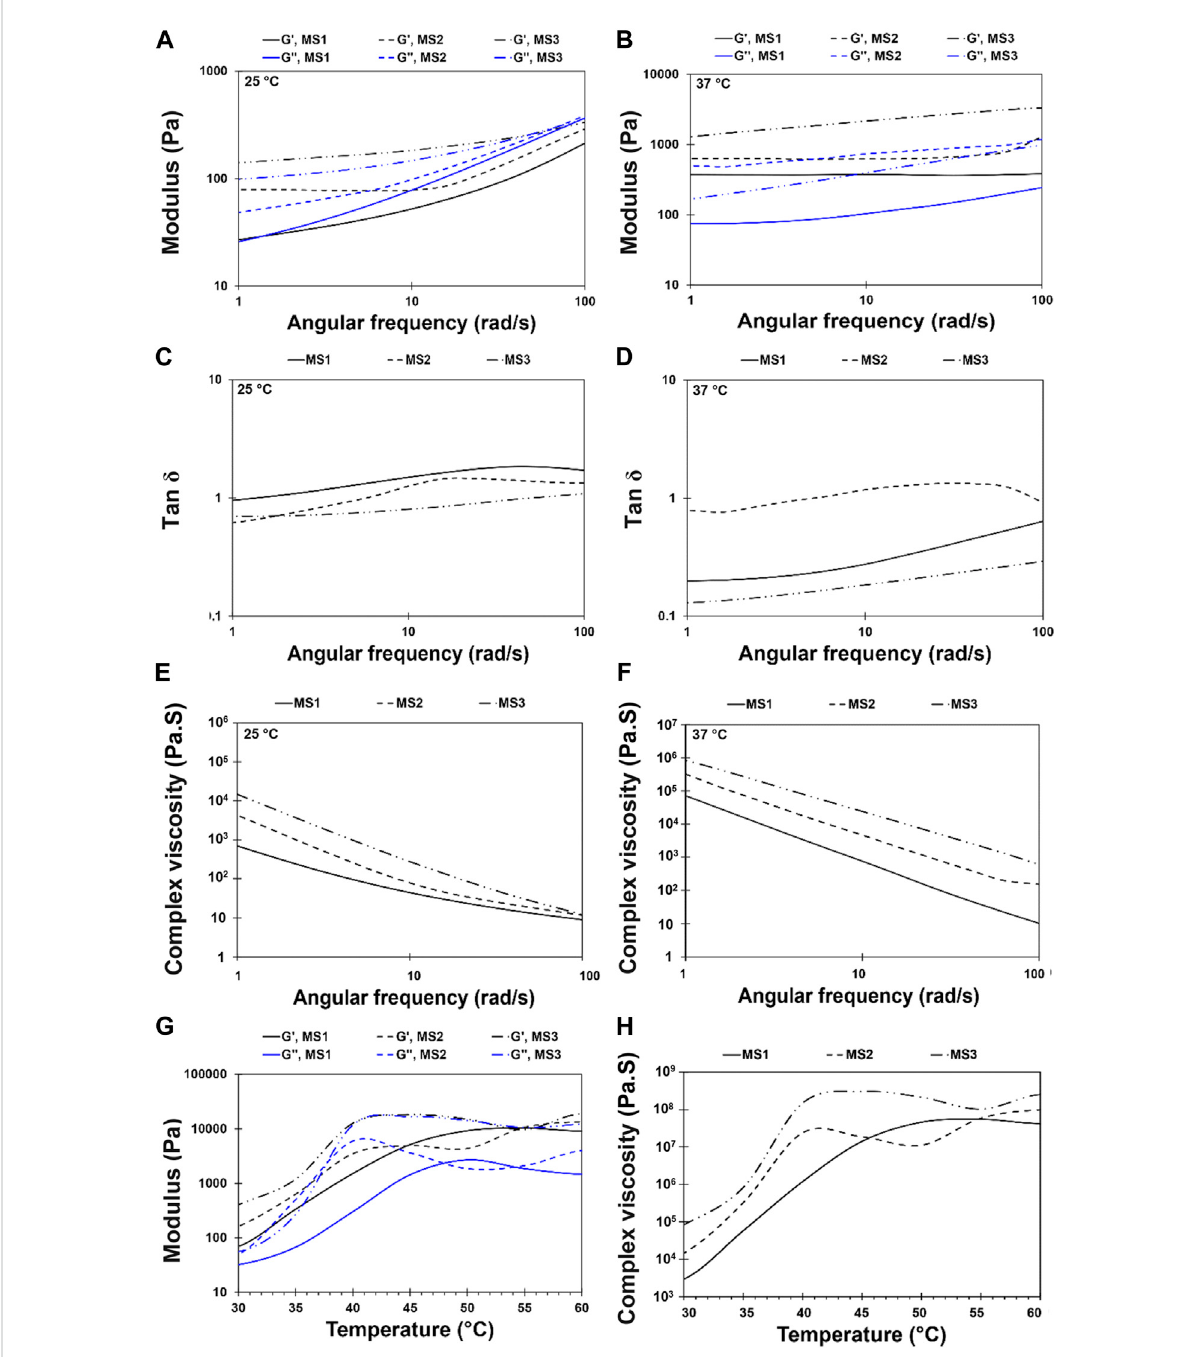
FIGURE 4 Rheologicalbehavior of light-assisted thermo-responsive methylcellulose-sodium humate hydrogels. Frequency sweep diagram at an angular frequencyof1 < ω < 100rad/sand10%strainforMS1,MS2,andMS3hydrogelsattemperature (A,C,E) 25±0.5 ° Cand (B,D,F) 37±0.5 ° C[ (A,B) Storage and loss modulus, (C,D) Tan δ , and (E,F) complex viscosity]. (G,H) Temperature sweep diagram at a constant angular frequency of 1 rad/s and temperature range of 30 to 60 ° C at a heating rate of 1 ° C/min for MS1, MS2, and MS3 hydrogels [ (G) Storage and loss modulus, and (H) complex